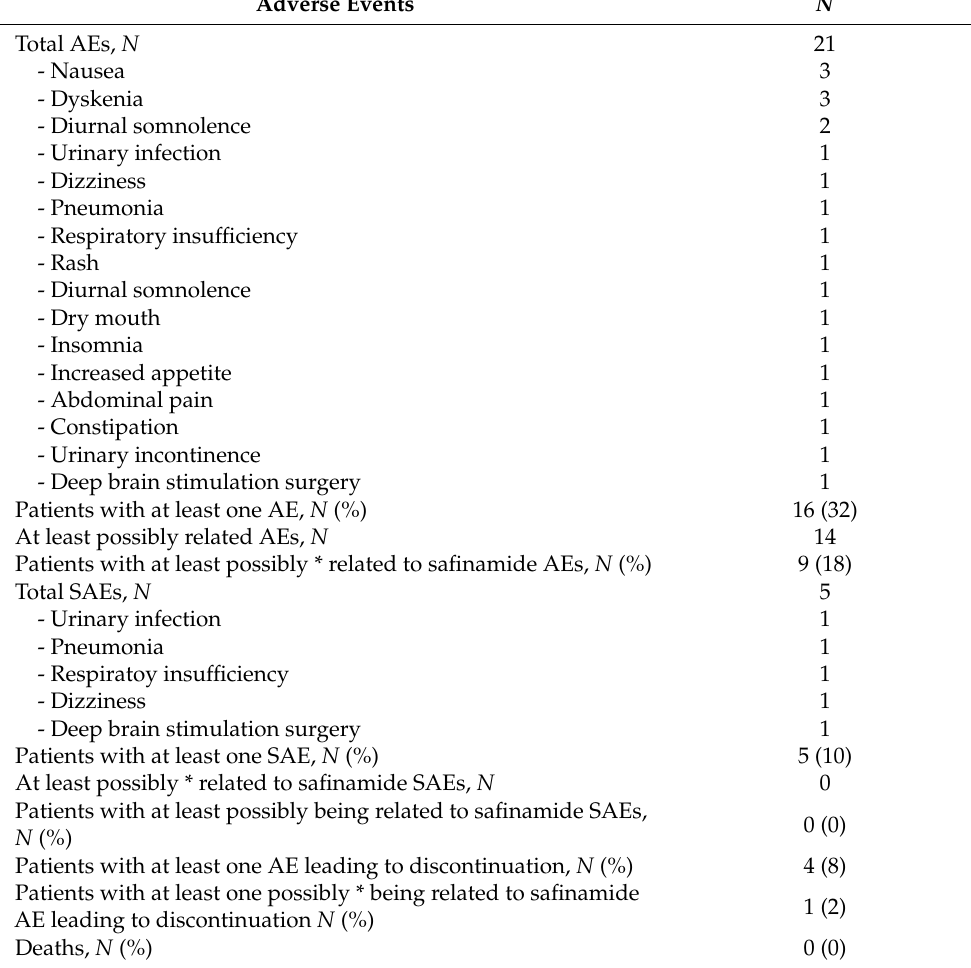
Table 3. Adverse events in patients from V1 to